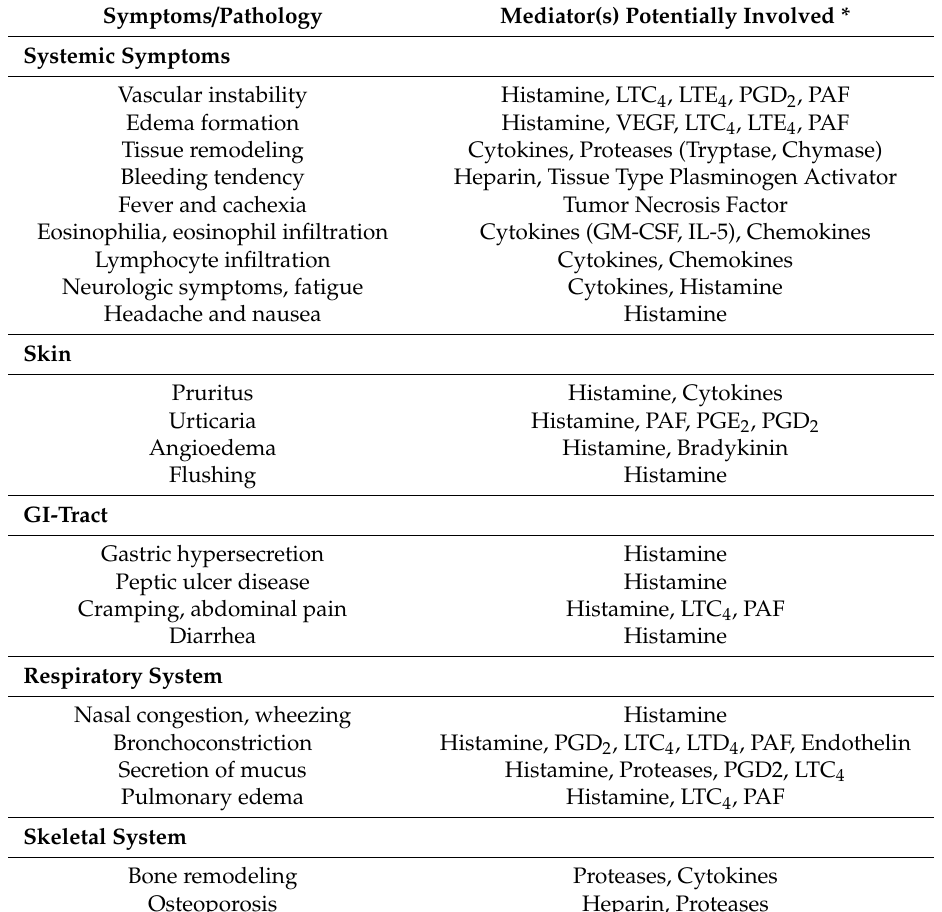
Table 1. Mast Cell-derived Mediators and Related Clinical Symptoms Symptoms / Pathology Mediator(s) Potentially Involved